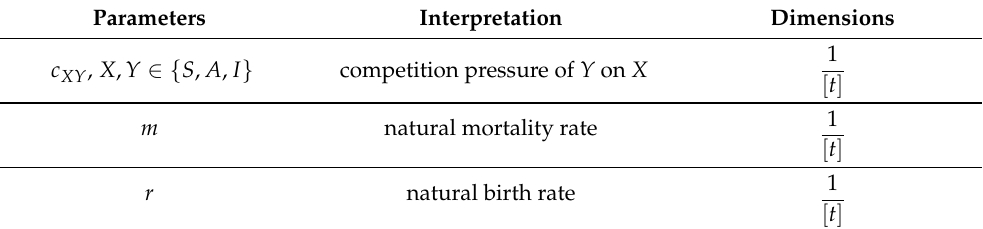
Table 1. Interpretation and dimensions of demographic parameters.